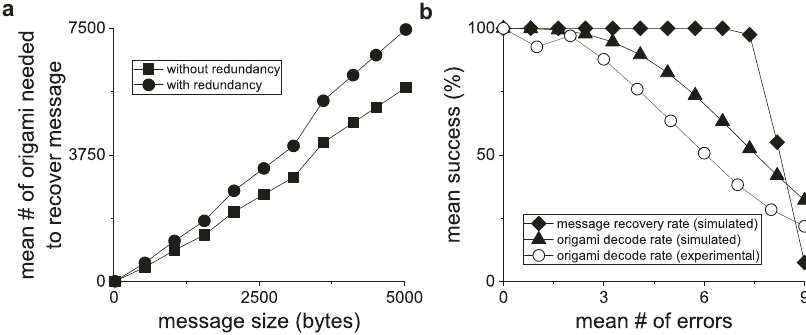
Fig. 5 dNAM origami and message recovery rates in the presence of increasing errors. Simulations were performed to determine the theoretical success rates for correctly decoding individual dNAM origami and recovering encoded messages. In ( a ), the mean number of dNAM origami needed to successfully recover messages of increasing length with (circles) or without (squares) redundant bits are plotted. In ( b ), the mean success for recovering both individual origami (triangles) and the entire message (diamonds) are plotted against the mean number of errors per origami (errors were randomly generated for simulated data). Simulation recovery rates are averages of all message sizes tested (160 to 12,800 bits). For comparison, the mean success rate for experimental data is also plotted (open circles). For experimental data, the mean success was estimated by comparing the decode algorithm ’ s results with that of the template-matching algorithm. All simulations were repeated 40 times. Experimental data were derived from 3 independent DNA- PAINT